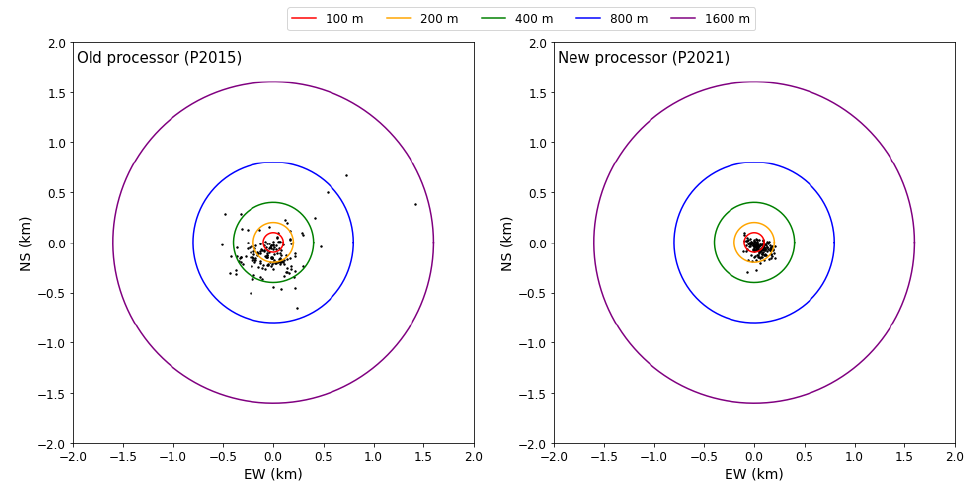
Figure 1. Locations of ENTLN pulses corresponding to return strokes in rocket-triggered lightning that are reported by P2015 ( left ) and P2021 ( right ). The ground-truth location (the position of the rocket launcher) is at the